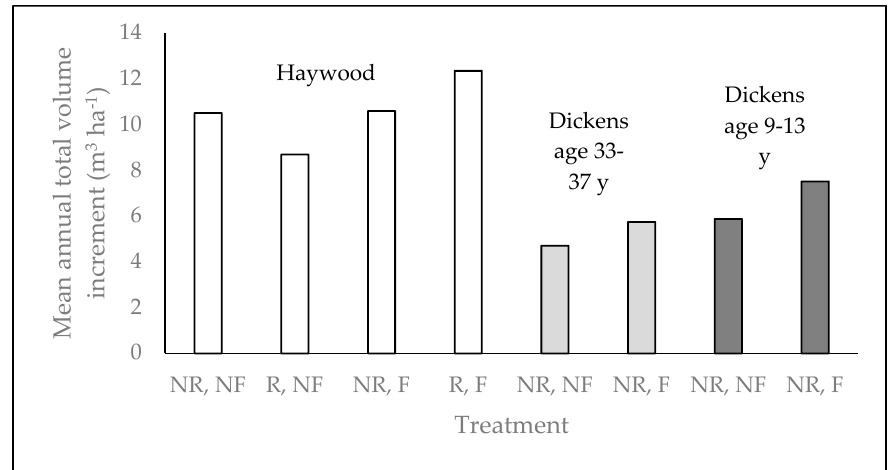
Figure 6. Longleaf pine mean annual volume ha growth by treatment [15,19,25]. Treatments: no rake, no fertilization (NR, NF); rake, no fertilization (R, NF); no rake, fertilization (NR, F); rake, fertilize (R, F) (refer to Tables 2 and 5 for study details, information on fertilizer treatments, and statistical test